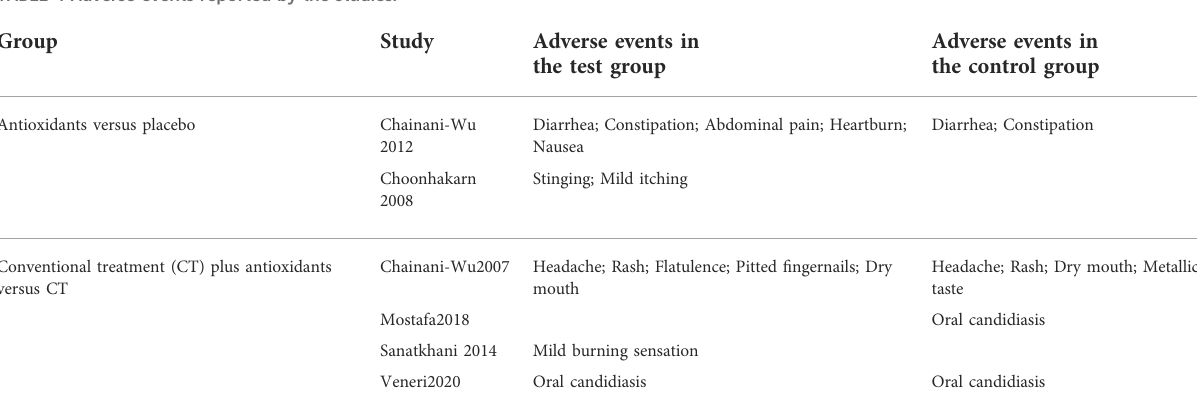
FIGURE 7 Forest plot of adverse